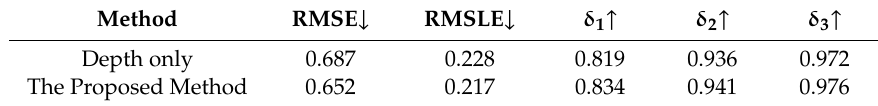
Table 2. Comparison of our method with depth only method using NYU Depth Dataset V2.